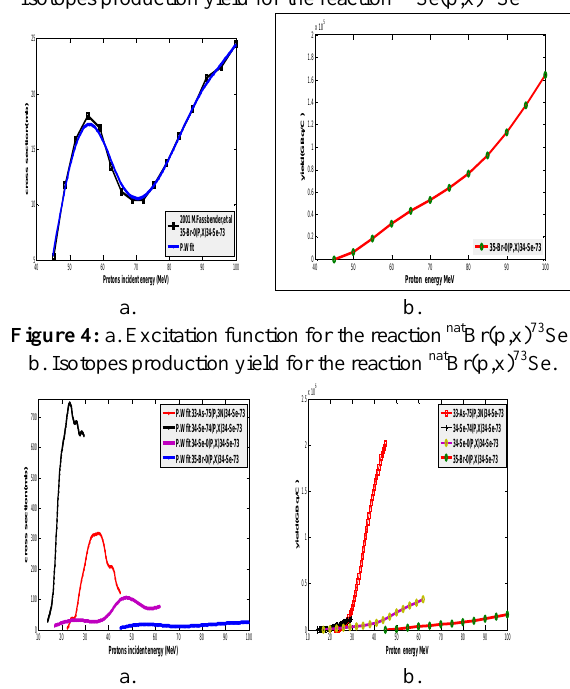
Figure 3 : a. Excitation function for the reaction nat Se(p,x) 73 Se. b. Isotopes production yield for the reaction nat Se(p,x) 73 Se